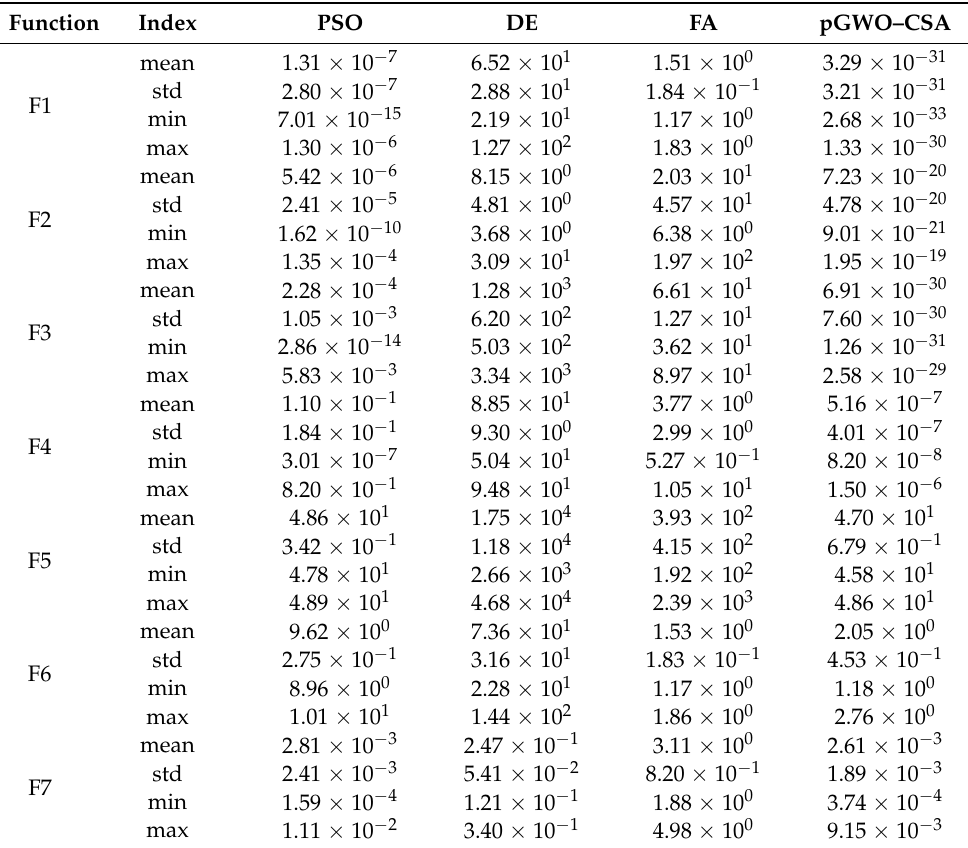
Table 4. The experimental results under 50